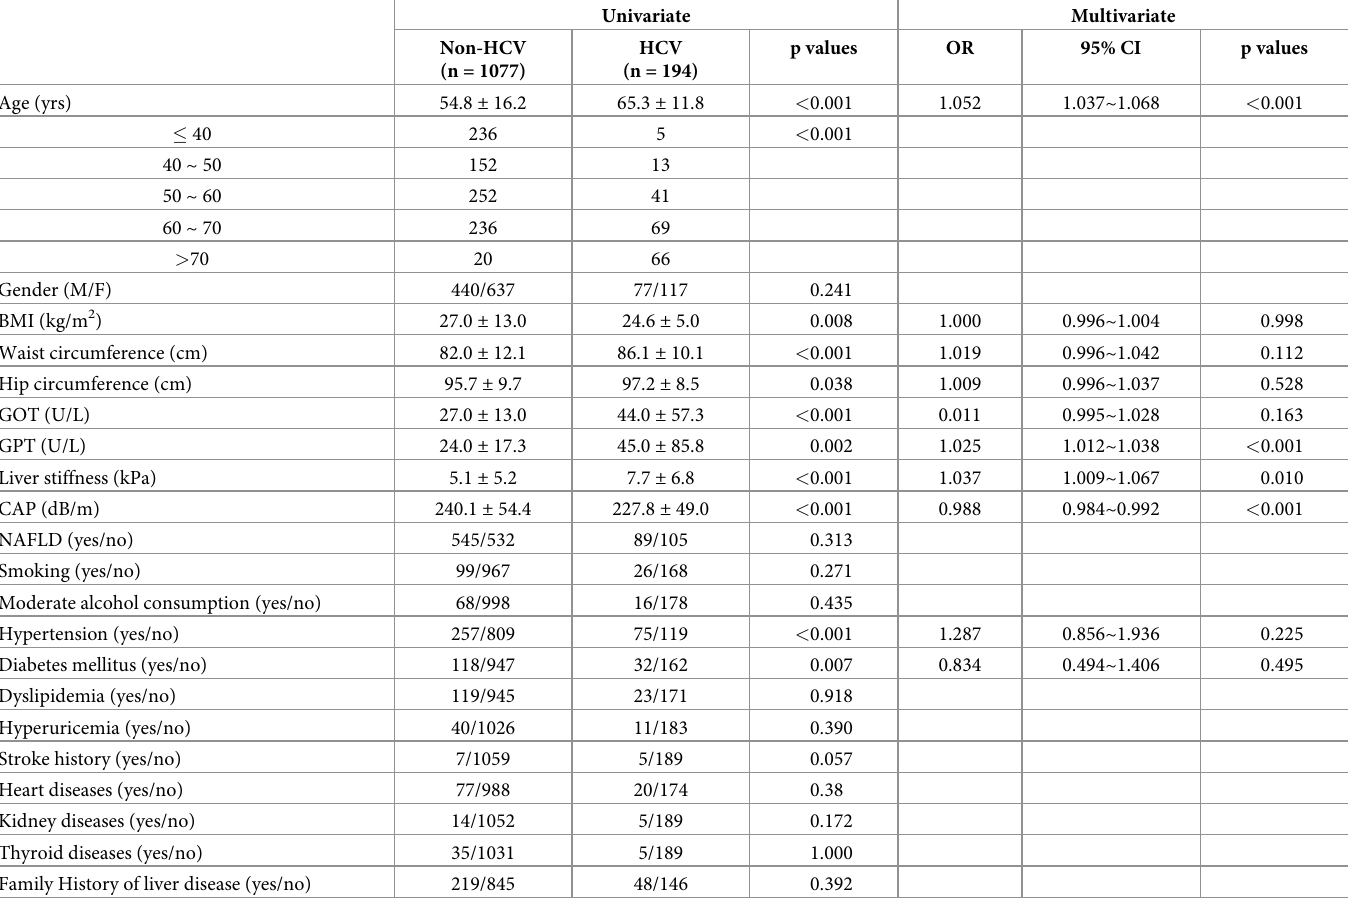
Table 1. Comparisons of demography of residents with status of HCV